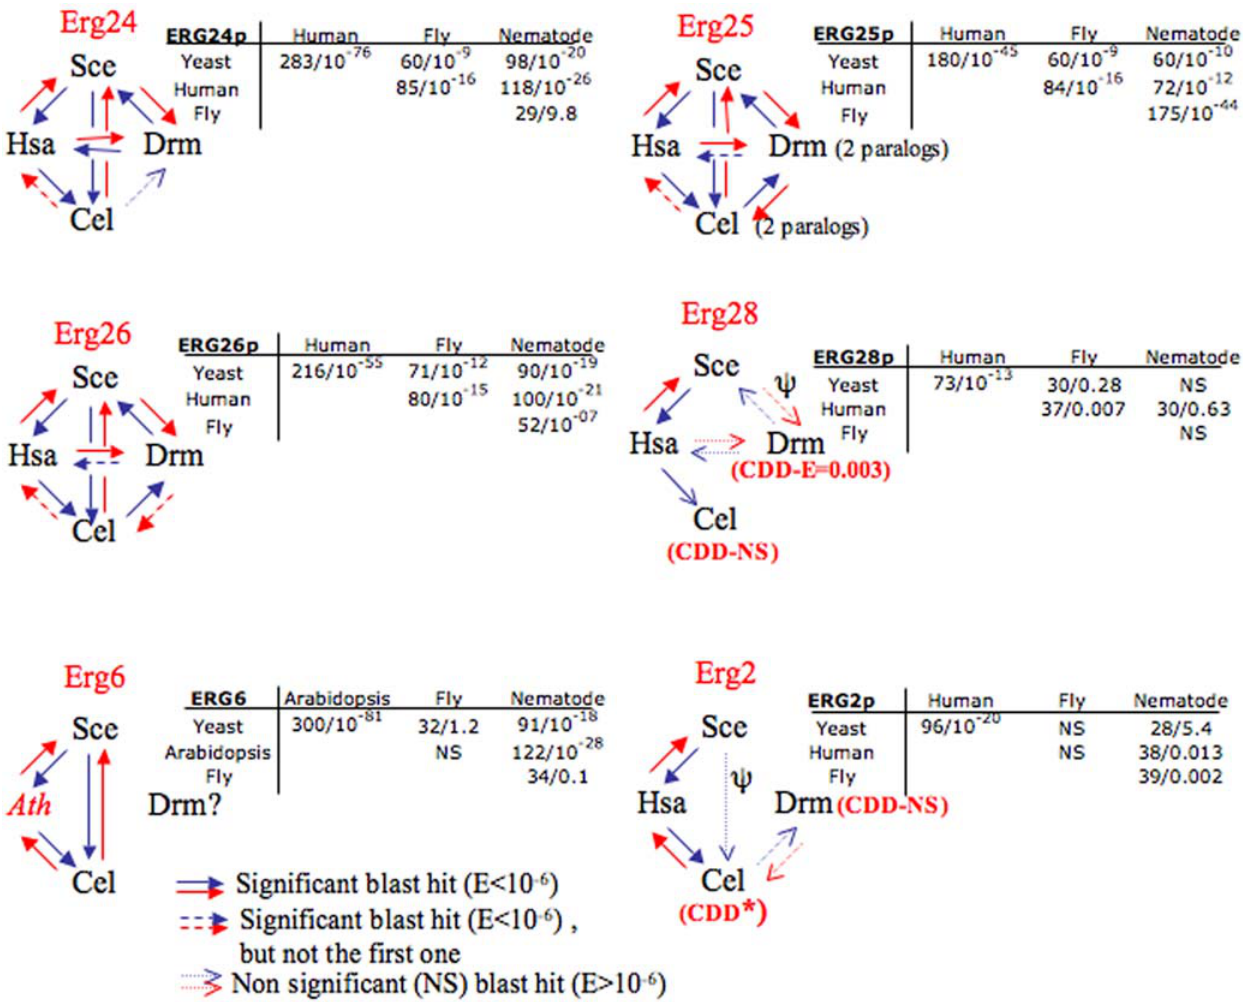
Figure 2. Details of the BLAST analysis that allowed the detection of ERG orthologs in C.elegans and D.melanogaster . The comparisons were performed in the directions indicated by the arrows (i.e. Yeast R Human represents a BLASTp search with an ERG protein from yeast in the division Homo sapiens of Genbank). Low Scores S and high E-values ( . 10 2 6 ) are classically considered as non-significant (unrelated or divergent sequences). The small tables display the S and E-values for the comparisons using the species-specific divisions of